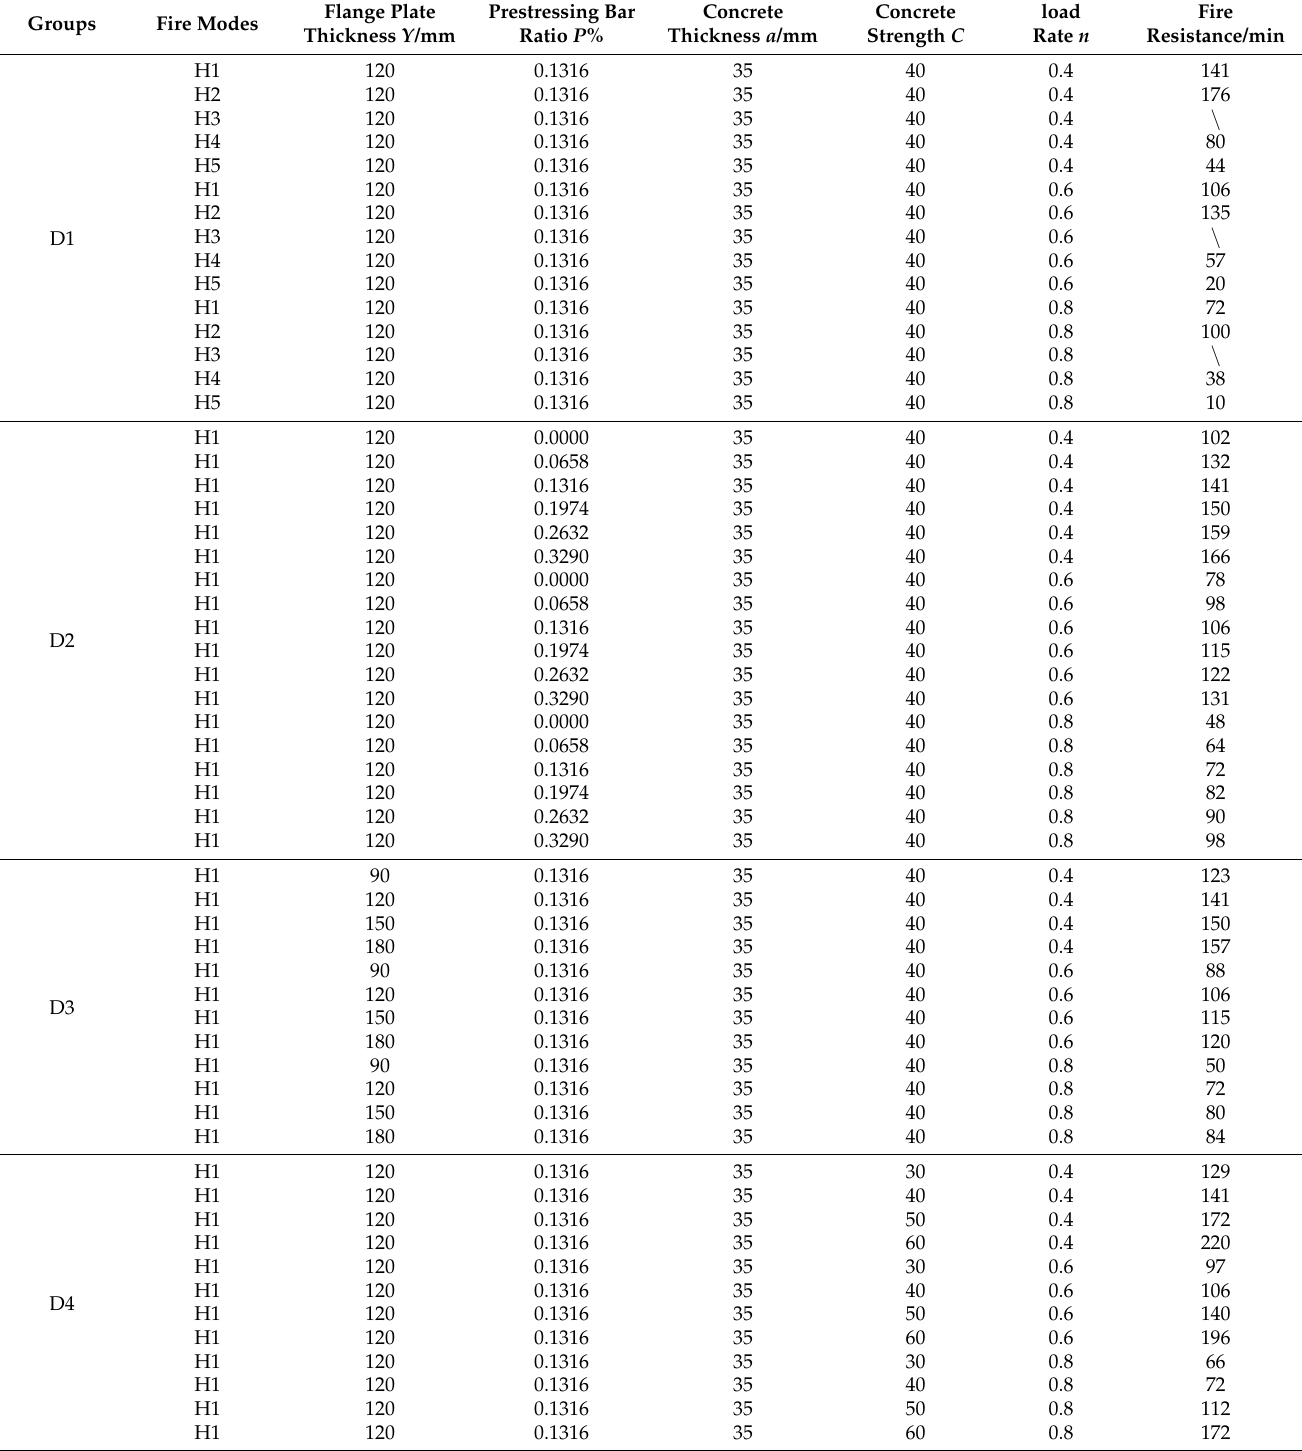
Table 6. Calculation results of fire resistance of prestressed concrete